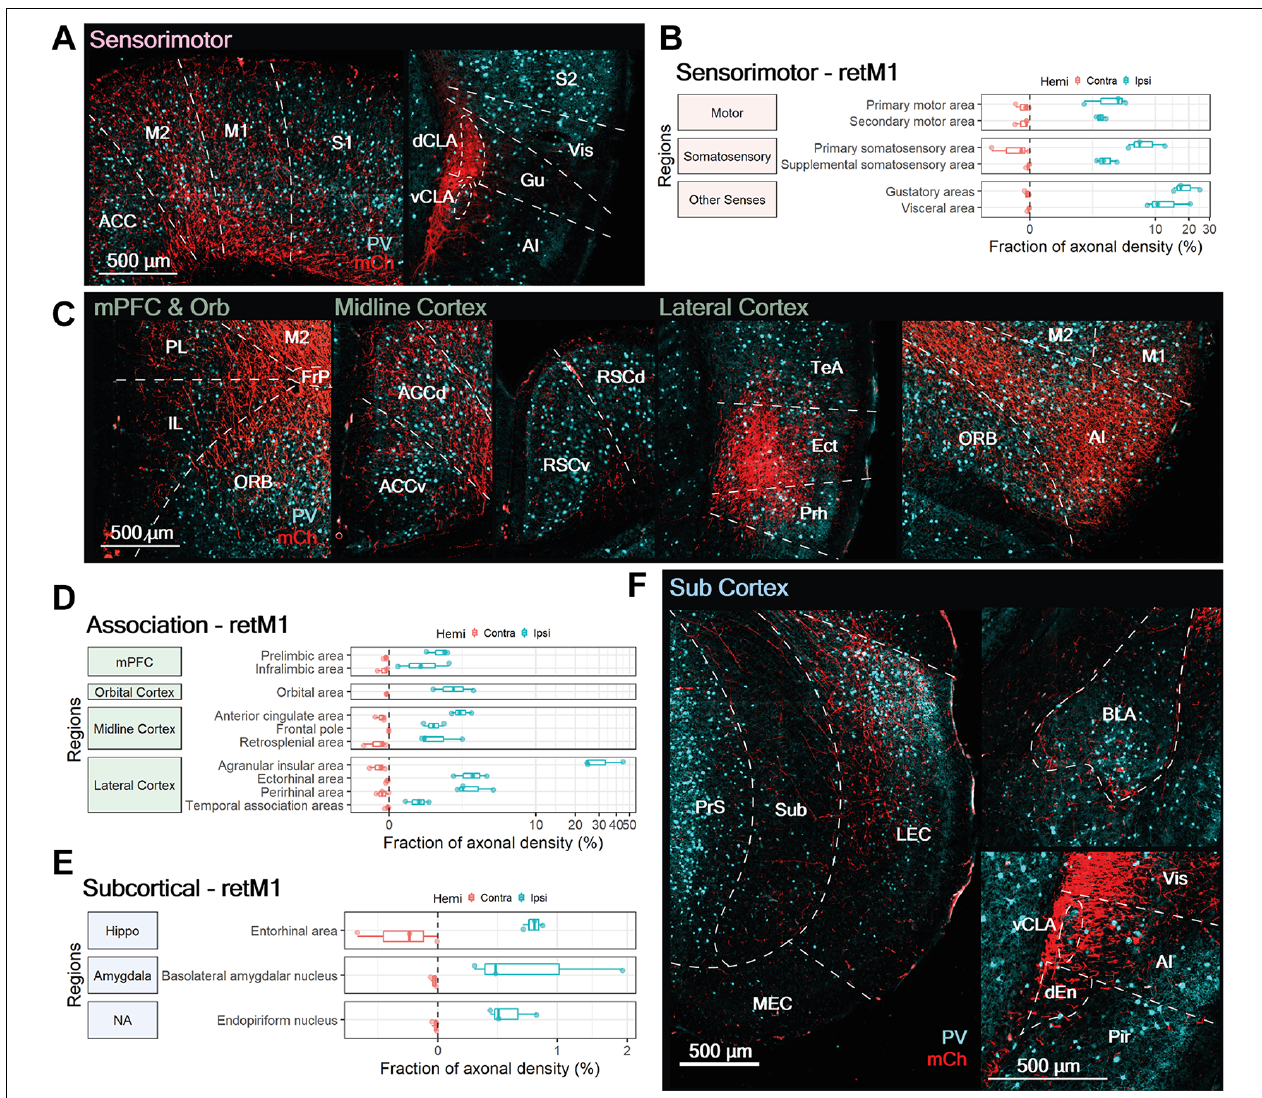
FIGURE 6 | M1-projecting CLA neurons heavily innervate select sensorimotor cortices, moderately innervate association-related regions and sparsely innervate subcortical regions. (A,C,F) Representative images from ipsilateral regions innervated by M1-projecting CLA neurons: (A) sensorimotor, (C) association, and (F) subcortical. mCherry labeled axons in red (mCh) and PV expression in cyan. (B,D,E) Quantification of regions innervated by M1-projecting CLA neurons in the contralateral (red) and ipsilateral (blue) hemispheres for (B) sensorimotor, (D) association, and (E) subcortical. Axonal density from each region is represented as a fraction of whole brain density; note that logarithmic scale. Region abbreviations: ACC, Anterior cingulate cortex; M2, M1, Secondary, primary motor cortex; S1, S2, Primary, secondary somatosensory cortex; dCLA, vCLA, dorsal, ventral claustrum; Vis, Visceral area; Gu, Gustatory area; AI, Agranular Insula; PL, Prelimbic cortex; IL, Infralimbic cortex; ORB, Orbital area; FrP, Frontal pole; ACC, ACCd, ACCv, Anterior cingulate cortex, dorsal, ventral; FrP, Frontal pole; RSCd, RSCv, Retrosplenial cortex dorsal, ventral; TeA, Temporal association area; Ect, Ectorhinal cortex; Prh, Perirhinal cortex; PrS, Presubiculum; Sub, Subiculum; LEC, MEC, Lateral,